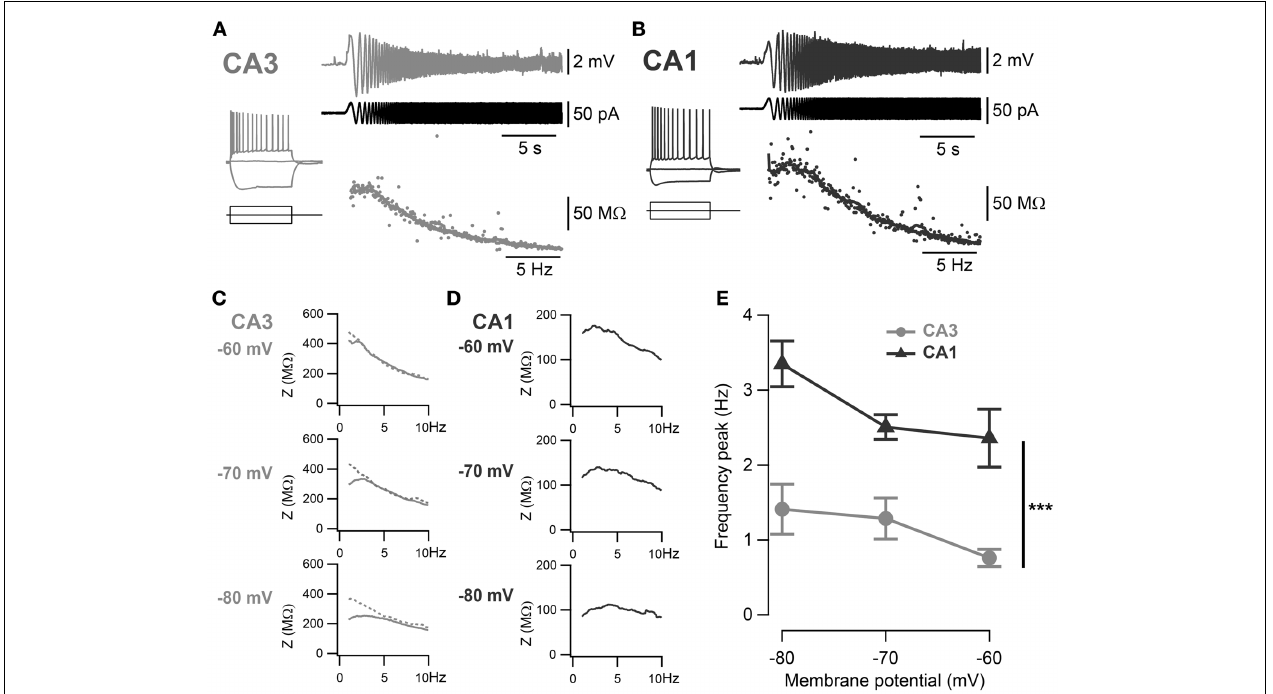
− 60, − 70 and − 80mV holding potentials. Some cells in CA3 did not show detectable frequency preference (dotted line) and a frequency preference could not be detected. (E) Average frequency preference of CA3 cells with resonance peak above 1 Hz ( n = 7) and all CA1 cells ( n = 12). Preferred frequency increased at more negative holding potentials and was significantly greater in CA1 than in CA3 cells ( ∗∗∗ p < 0 . 001, One-Way ANOVA with Bonferroni post-hoc test).